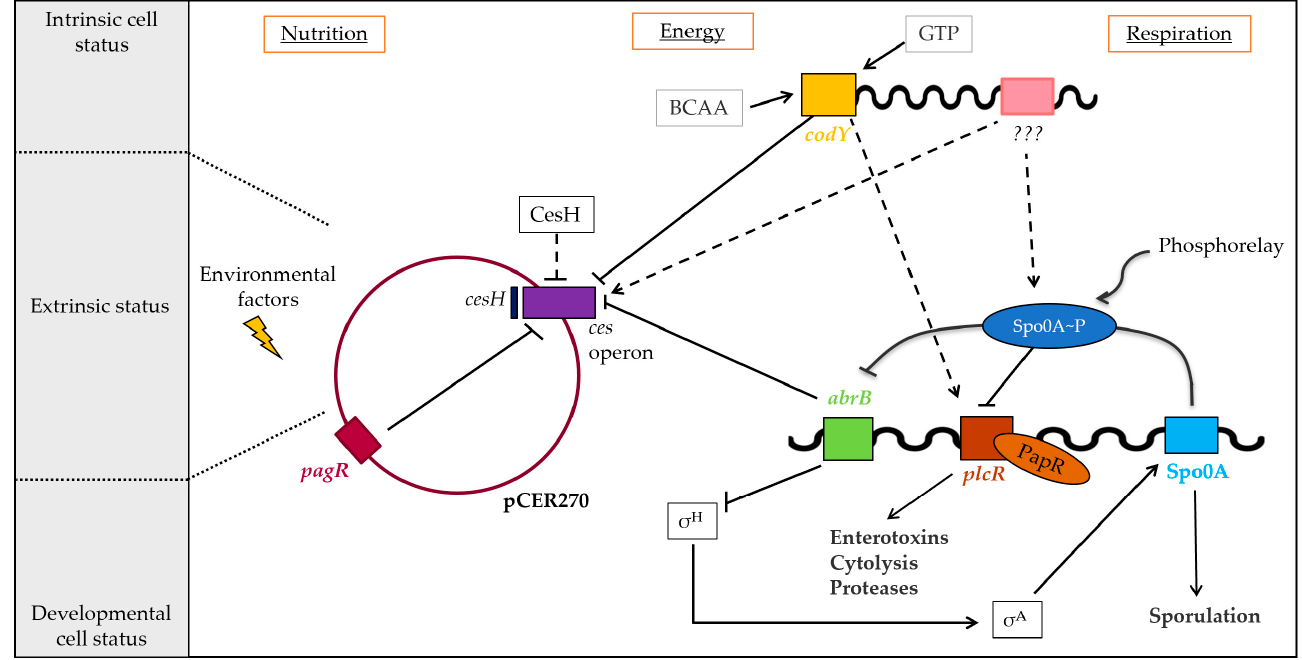
Figure 7. Regulation of cereulide toxin synthesis of emetic B. cereus . Cereulide toxin synthesis is a complex and multilayered process, orchestrated by the interplay of chromosomally and plasmid- encoded factors controlling the toxin synthesis at the transcriptional and post-transcriptional levels. The ces operon is tightly controlled by the chromosomally encoded global transcriptional regulators CodY and the transition phase regulator AbrB that belongs to the Spo0A regulon, but not by the pleiotropic B. cereus virulence regulator PlcR. The putative hydrolase CesH, encoded adjacent to the ces operon, indirectly controls cereulide biosynthesis, while the ArsR/SmtB family repressor PagRBc on pCER270 plasmid exerts control of ces transcription. Solid arrows: transcriptional regulation; dashed arrows: indirect regulatory effects (adapted from [24]).